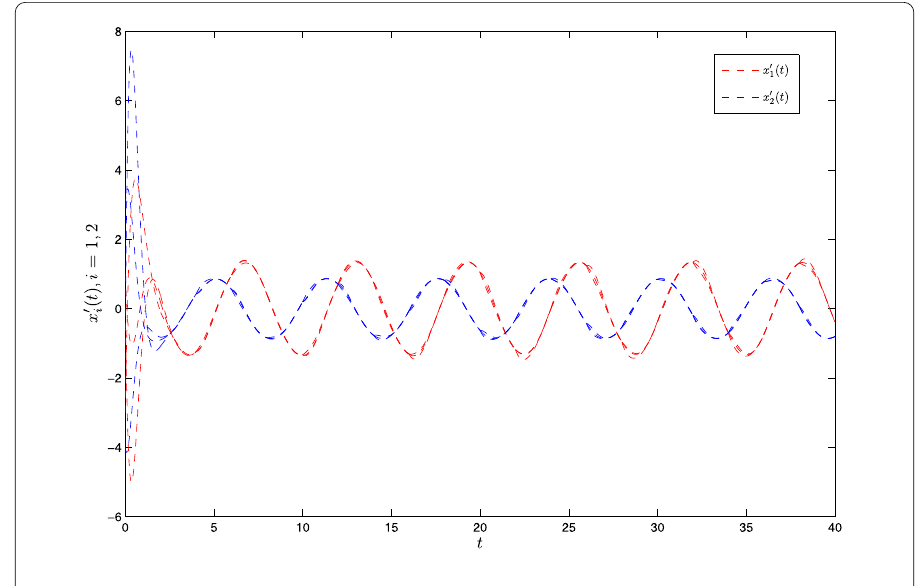
Figure 2 Numerical solutions x (cid:2) ( t ) on system (3.1). Numerical solutions x (cid:2) ( t ) to example (3.1) with initial values: (sin t + 1,–cos t – 3,cos t ,sin t ),(2cos t + 2,3sin t – 1,–2sin t ,3cos t ),(–3sin t – 2,–4sin t + 3,–3cos t ,–4cos t )